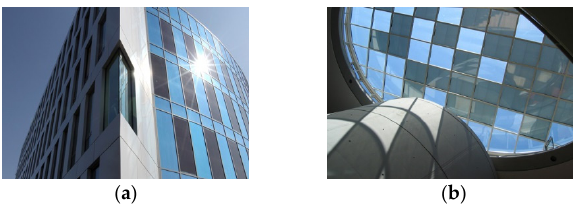
Figure 2. Examples of BIPV as solar cell glazing products for facades ( a ) and roofs ( b ) (ASI Glass photovoltaic modules, Schott Solar AG [6]).